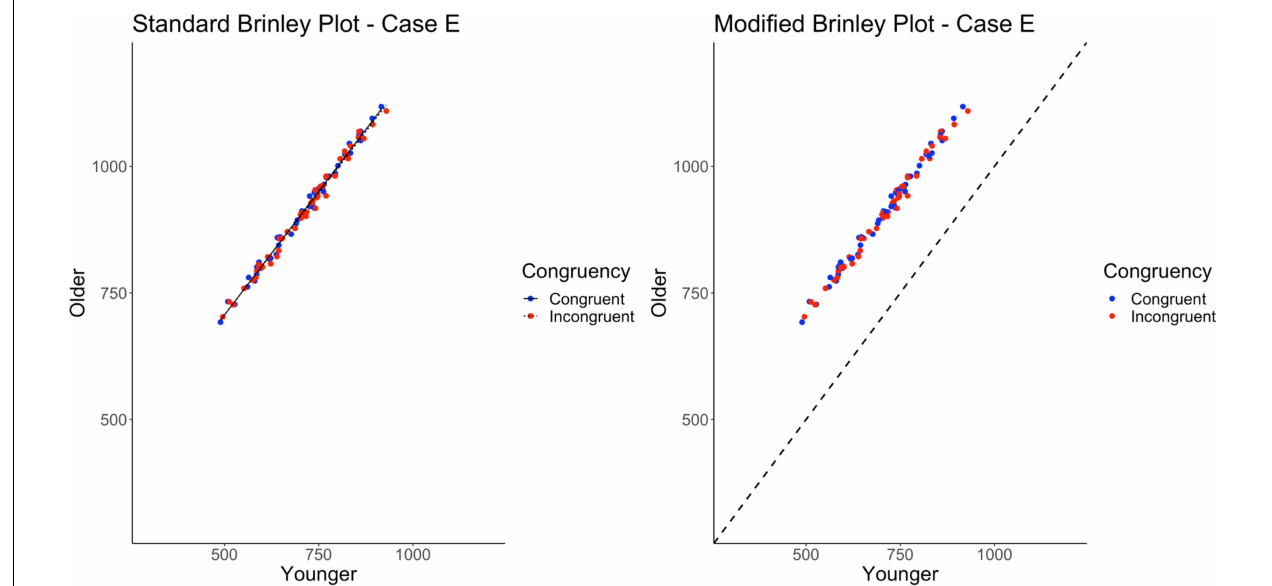
FIGURE 7 | Standard and modified Brinley plots—Case E data. Standard and modified Brinley plots (left and right, respectively) for the Case E simulated data which was simulated such that there was only a main effect of age. Means (SD) used for Case E were as follows: Young Congruent = 700 (150), Young Incongruent = 700